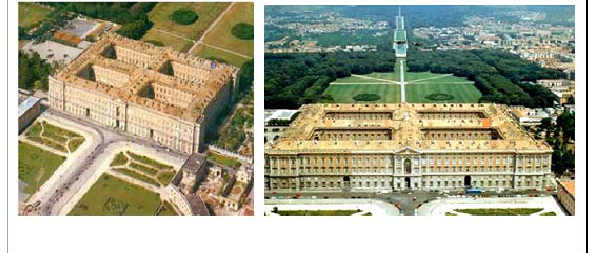
Figure 1.Royal Palace in Caserta